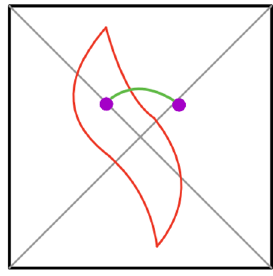
Figure 8 . Asymmetric black hole pair creation. The red curves represent the world-lines of a pair of black holes which are created and annihilated behind the